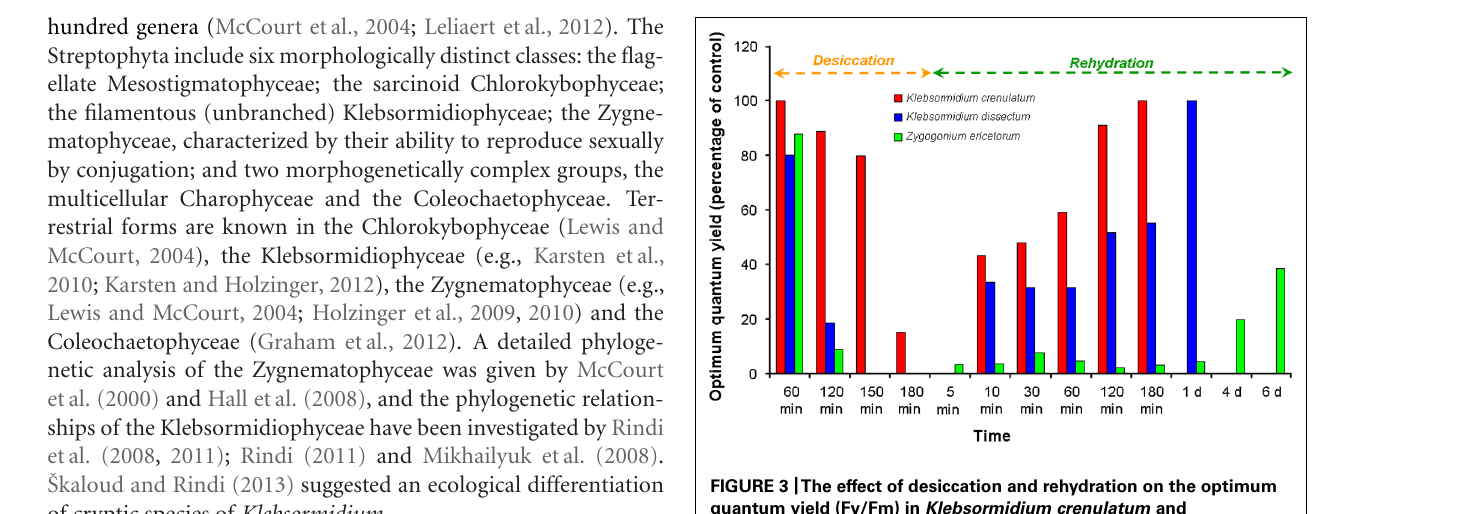
sp., Scenedesmus rotundus, and Chlorosarcinopsis sp., and the Tre- bouxiophycean genera Chlorella sp. and Myrmecia sp.